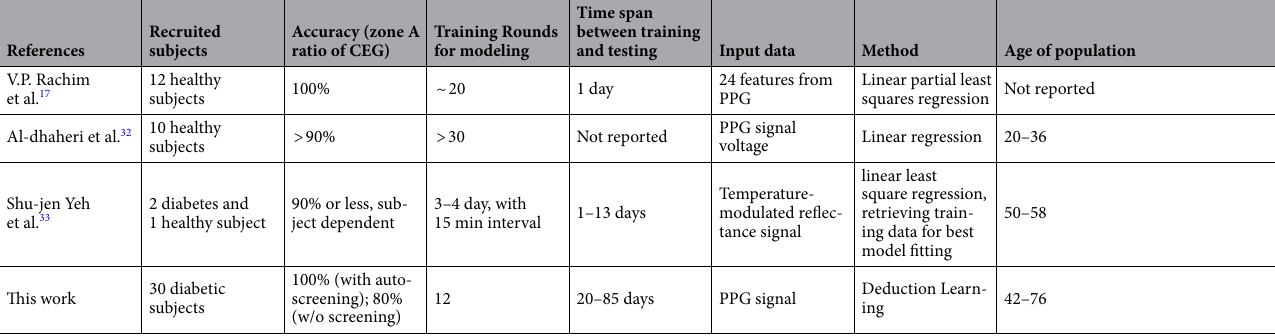
Table 1. Comparison of PPG based NIBG with personalized